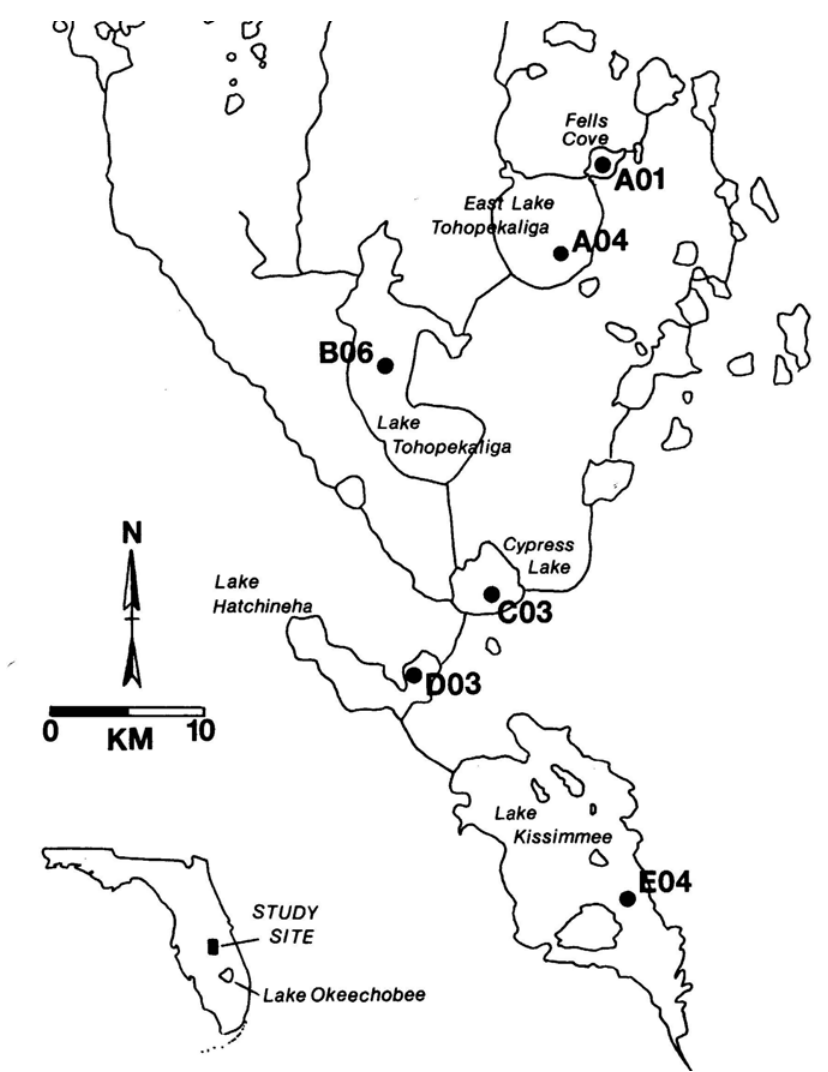
FIGURE 1 . Map of the six study lakes and the sampling locations where data were collected in this project. The inset map shows the location in Florida, U.S. Station names (A01œE04) correspond to those used in the long-term water quality monitoring database of the South Florida Water Management District. The full water quality database can be accessed for any of these sites (period of record 1988 to present) from www.sfwmd.gov species was determined from published length-weight relationships[26]. In the case of D. lumholtzii, the equation for D. pulex was used, with a 15% additive term to account for the larger head and tail spines of -1 D. lumholtzii . Zooplankton population biomass values ( μ g l ) were determined by multiplying numeric densities times the estimates of individual biomass.